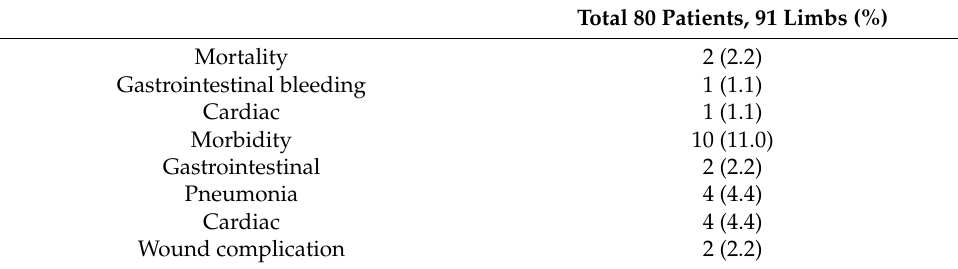
Table 4. Perioperative complications of common femoral